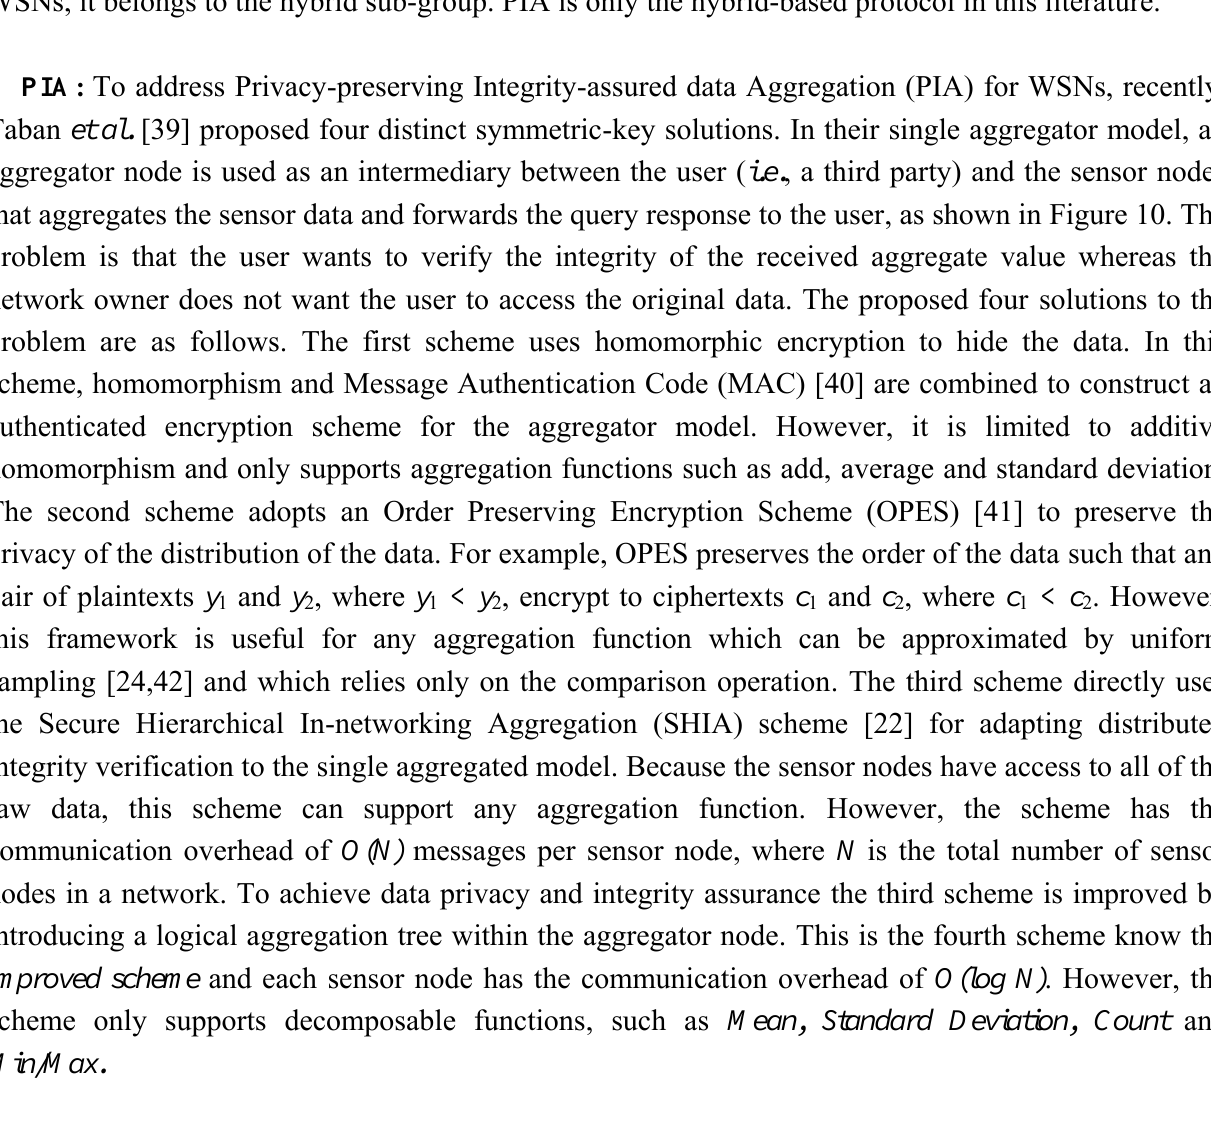
Figure 10. Data aggregation from sensors A, B and C with two aggregators X and